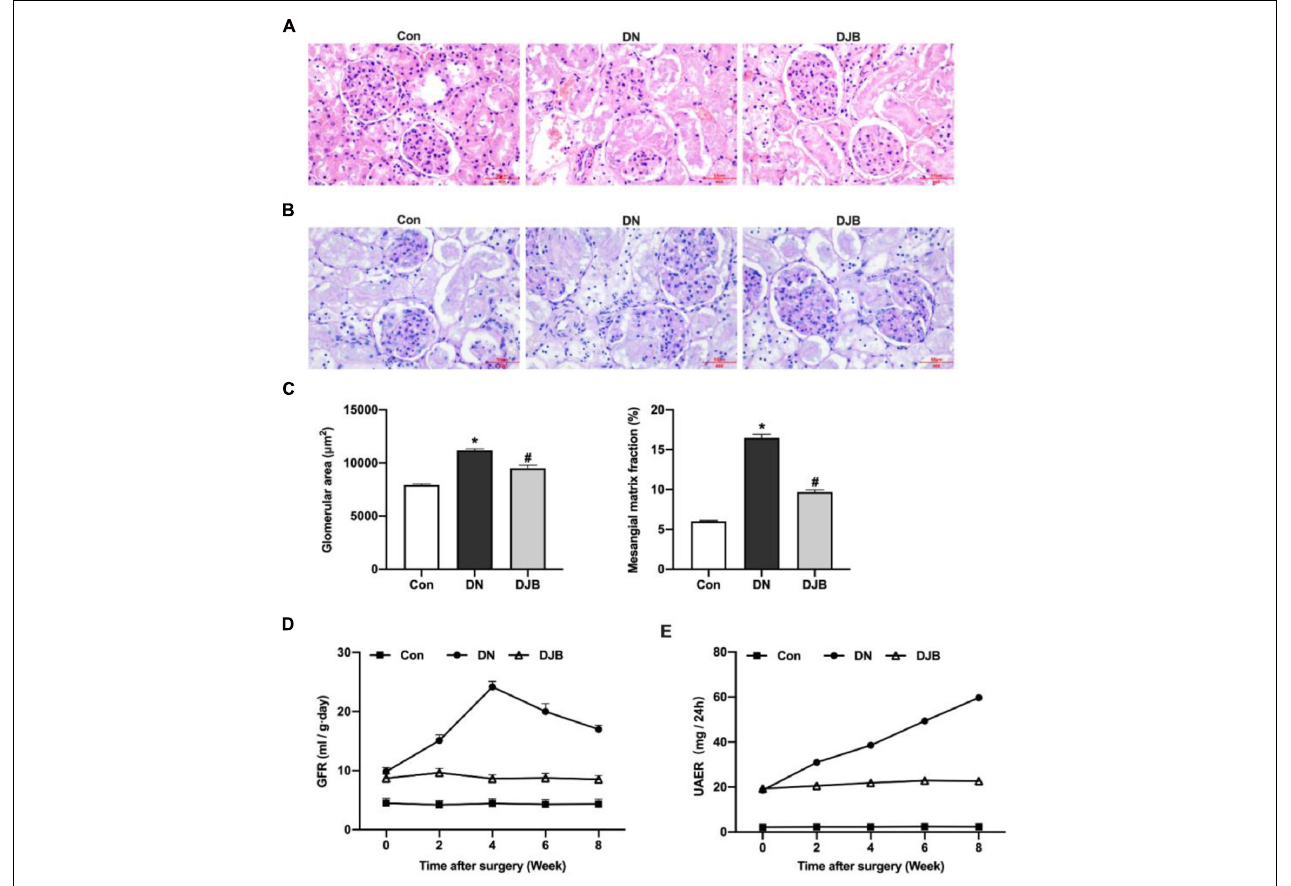
FIGURE 2 | Bariatric surgery improved renal dysfunction in diabetic rats. Representative photomicrographs of the kidney sections observed with hematoxylin–eosin (H&E) staining (A) and periodic acid–Schiff (PAS) staining (B) ( scale bar , 50 µ m). Glomeruli in the kidney sections were visualized with H&E staining. The area of the mesangial matrix ( pink / purple between the capillary loops) was seen on the PAS stain for collagen. (C) Quantification and comparison of the glomerular area and extra-mesenchymal matrix fraction. The histograms represent data from examining 25–50 individual glomeruli in sections from four individual mice in each group. Glomerular filtration rate (GFR) (D) and urinary albumin excretion rate (UAER) (E) monitored in 8 weeks. All data represented the mean ± SD. * p < 0.05 [compared with the control (Con) group]; # p < 0.05 [compared with the diabetic nephropathy (DN) group].